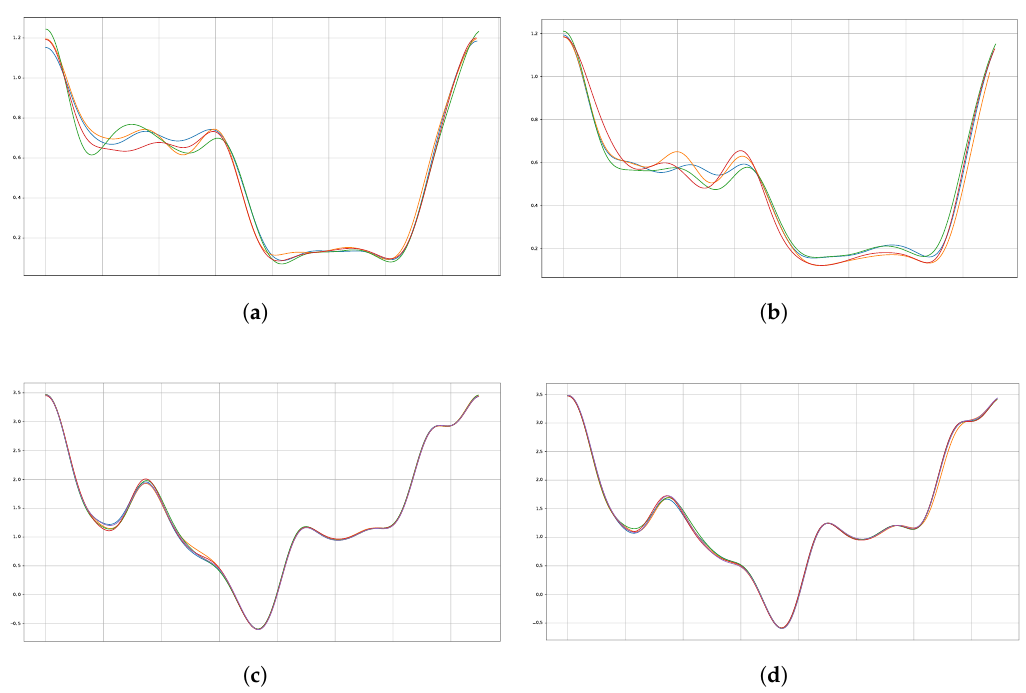
Figure 14. Comparison of the same electrical turn voltage over 4 mechanical turns for different speeds and phases. ( a ) Phase A—Electrical turn n.1—3000RPM—healthy motor; ( b ) Phase A—Electrical turn n.1—3000RPM—partially demagnetised motor; ( c ) Phase C—Electrical turn n.5—9000 RPM—healthy motor; ( d ) Phase C—Electrical turn n.5—9000RPM—partially demagnetised